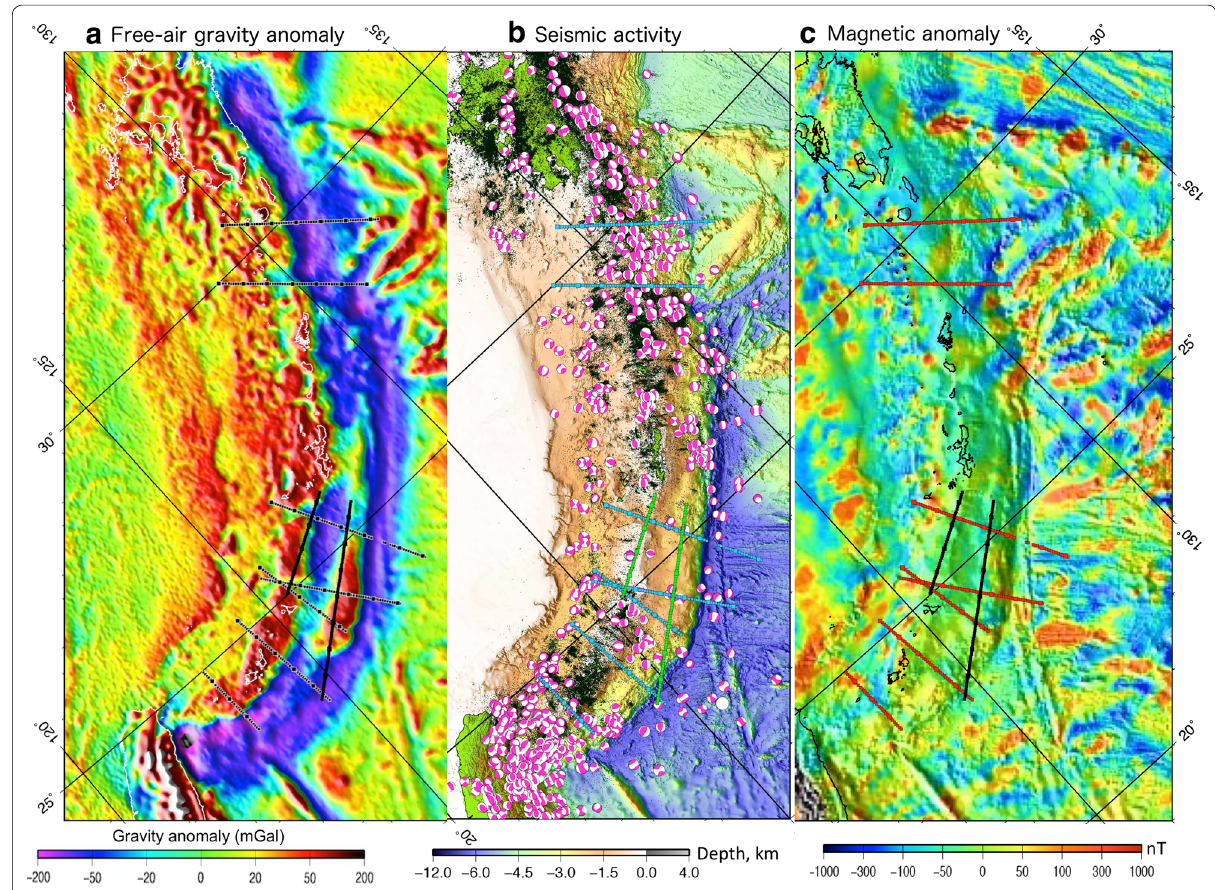
Fig. 2 Geophysical maps of the survey area. a Free-air gravity anomaly. b Shallow seismic activity. Black dots show epicenters with depths shallower than 60 km as determined by the Japan Metrological Agency (1923–2017 Feb. 20). Focal mechanisms are from GCMT Catalog by Global Centroid- Moment-Tensor Project (depth 60 km, 1976–2017 May 31). c Magnetic anomaly on bathymetry. The magnetic anomaly map is produced by a ≤ combination of our original data, CCOP (http://www.ccop.or.th/), and EMAG2